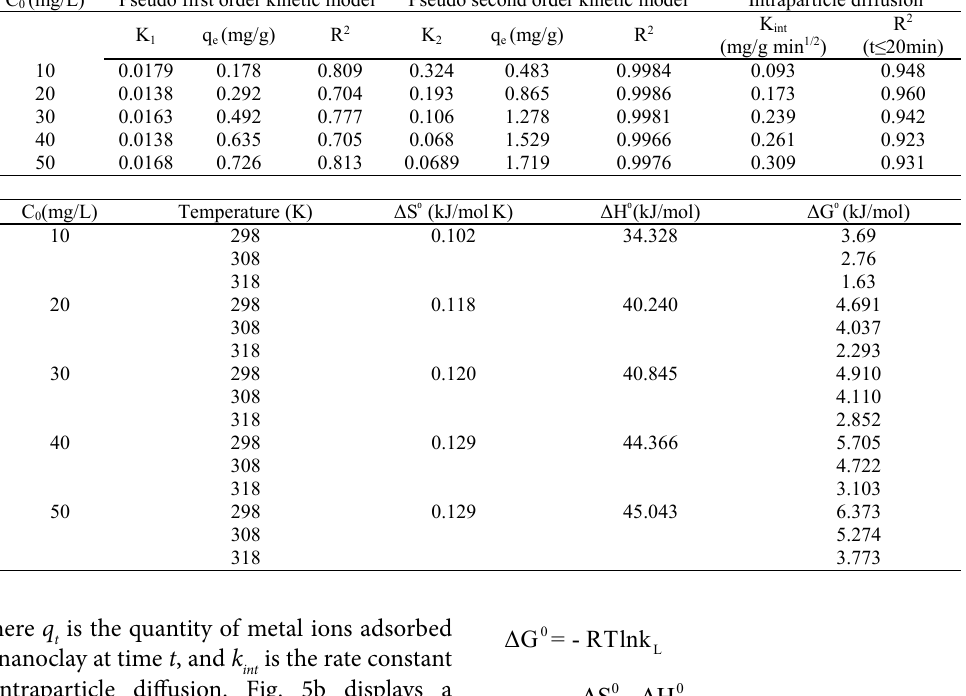
Table 5 Adsorption kinetics models and thermodynamic parameters of Hg(II) ions adsorption. Table 5. Adsorption kinetics models and thermodynamic parameters of Hg(II) ions C 0 (mg/L) Pseudo first order kinetic model Pseudo second order kinetic model